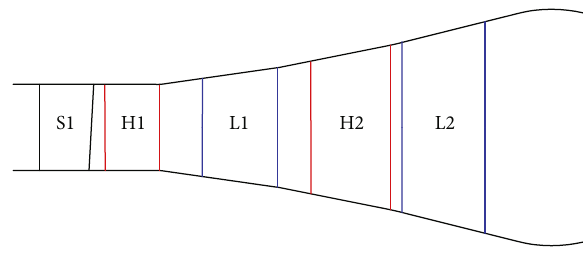
Figure 1: Staggered counter rotating